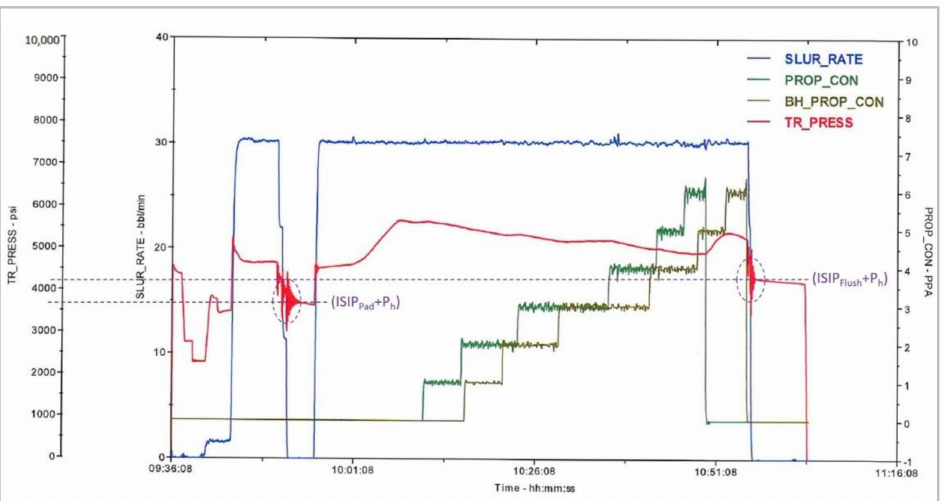
Figure 8. ISIP in pad and flush injection phases from surface treatment pressure records in multistage hydraulic fracturing. (Note: These curves are not from Wolfcamp